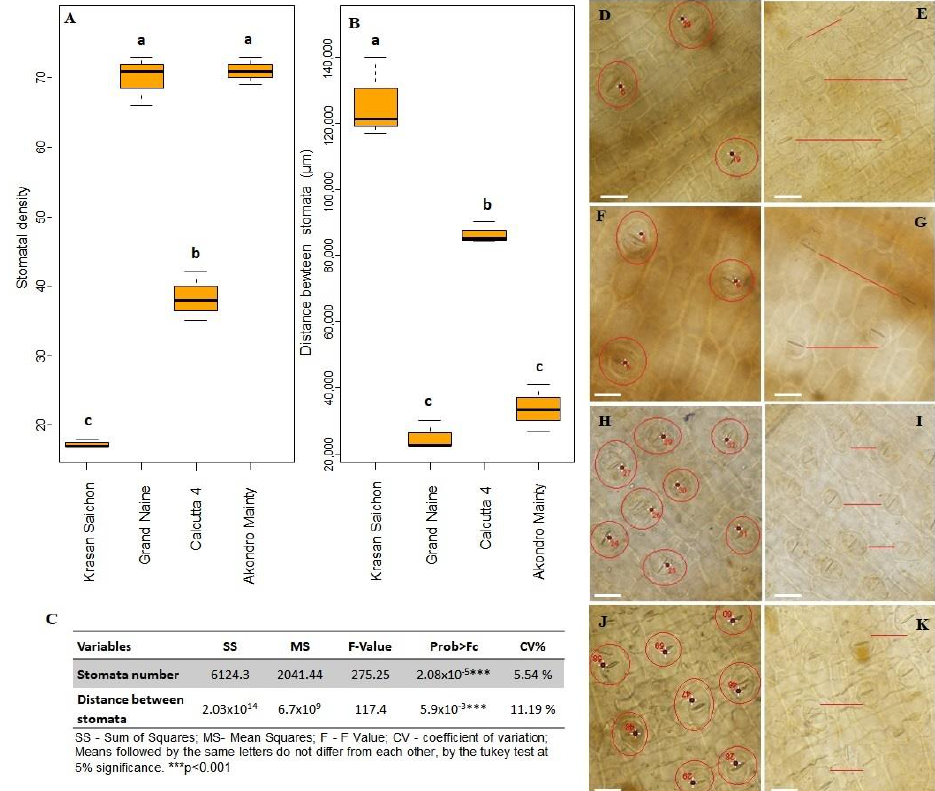
Figure 5. Stomatal analyses of banana genotypes evaluated for resistance to black Sigatoka: box plots of stomatal density ( A ) and distance between stomata ( B ); means followed by the same letter do not differ according to Tukey’s test at 1% significance. Counts of the number of stomata in measurements of distance between stomata in Calcutta 4 ( D , E ), Krasan Saichon ( F , G ), Grand Naine ( H , I ) and Akondro Mainty ( J , K ). Bar: 200 μm. Tukey’s test at 5% significance ( C ).